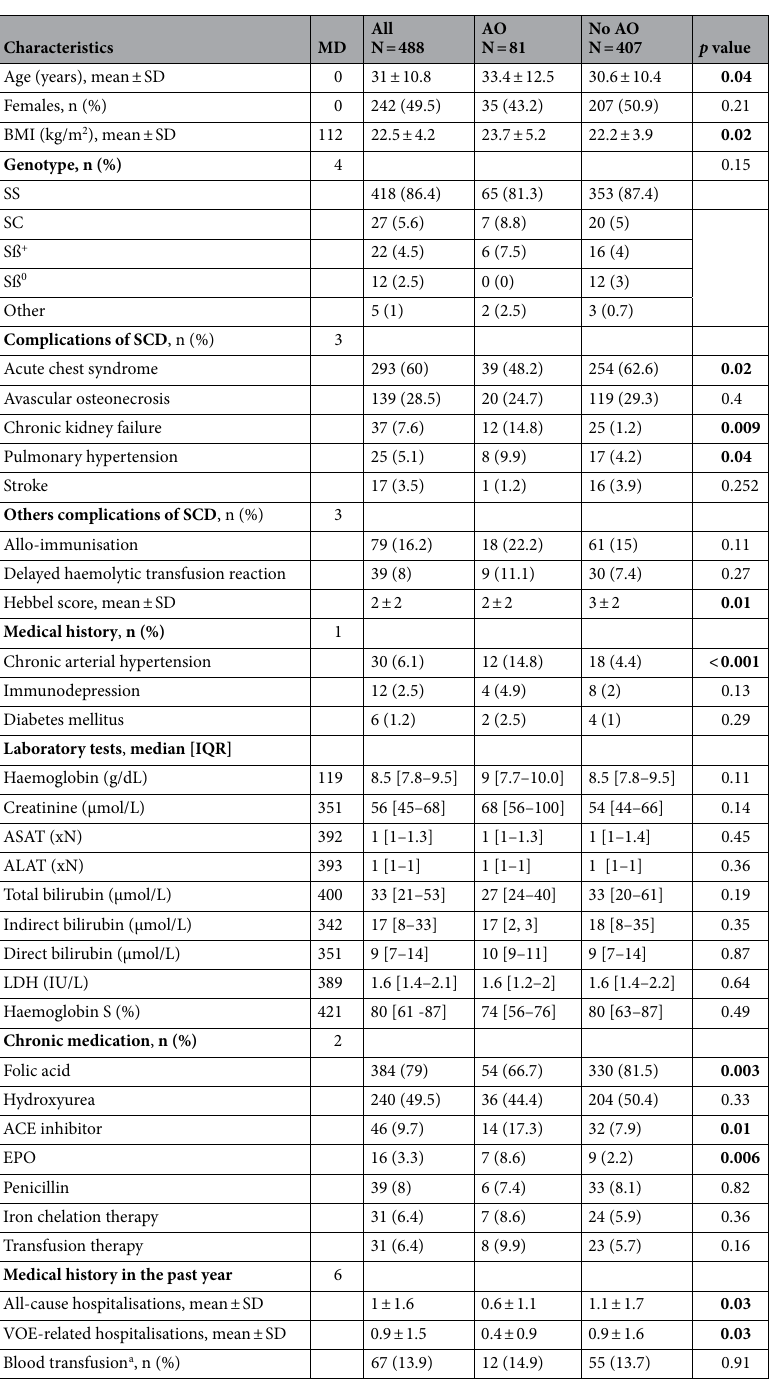
Table 1. Patient characteristics before hospital admission (stable status). Significant values are in [bold]. MD missing data, AO adverse outcome defined as death in the ICU or use of life-sustaining treatments, BMI body mass index, ACE angiotensin-converting enzyme, EPO erythropoietin, VOE vaso-occlusive event, SD standard deviation, IQR interquartile range. a Except prophylactic red blood cell